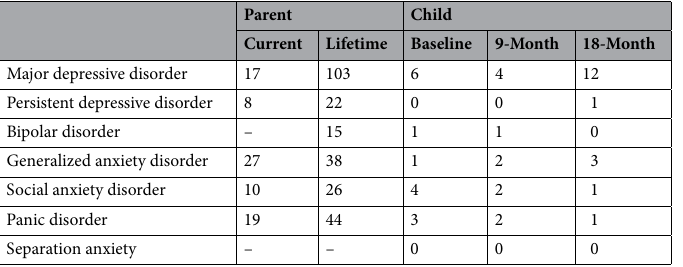
Table 2. Parent and child internalizing disorders diagnoses. Breakdown of past diagnoses at baseline and new onsets at follow-up in children and parent current and lifetime diagnoses. There is overlap between